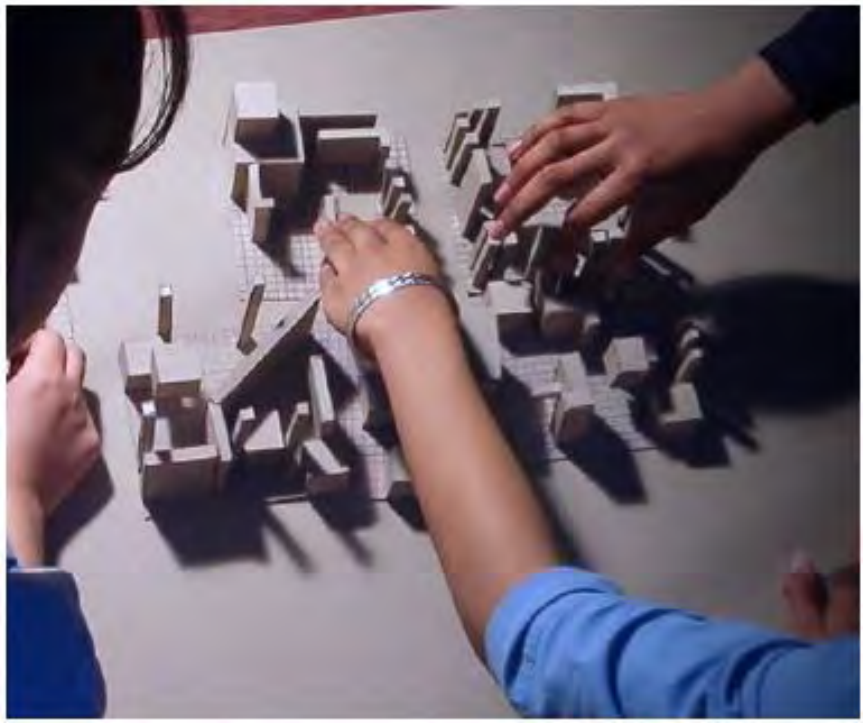
Figure 4. Design students working on a traditional kit of parts project